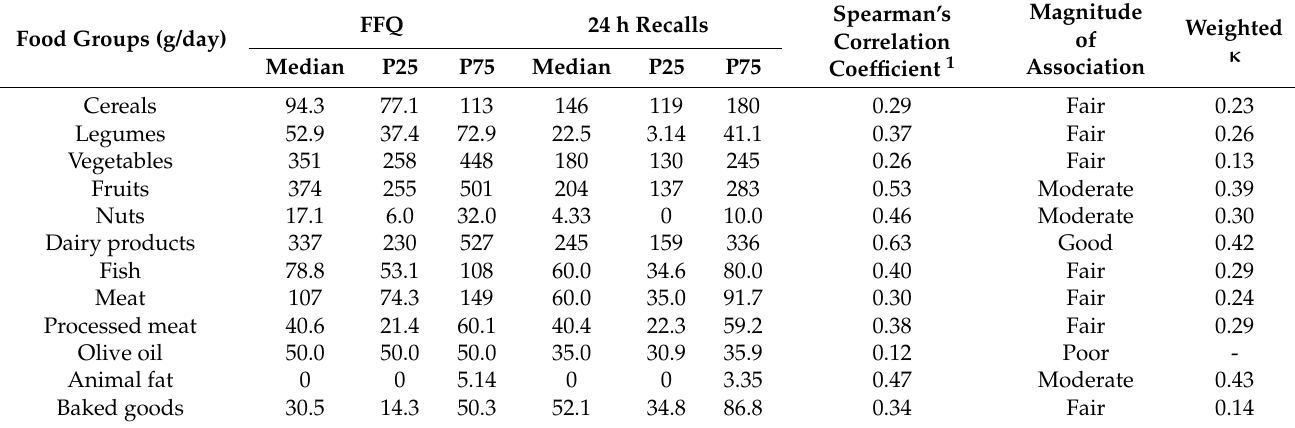
Table 3. Concurrent validity and concordance of foods and nutrients derived by the food frequency questionnaire and dietary records ( n =